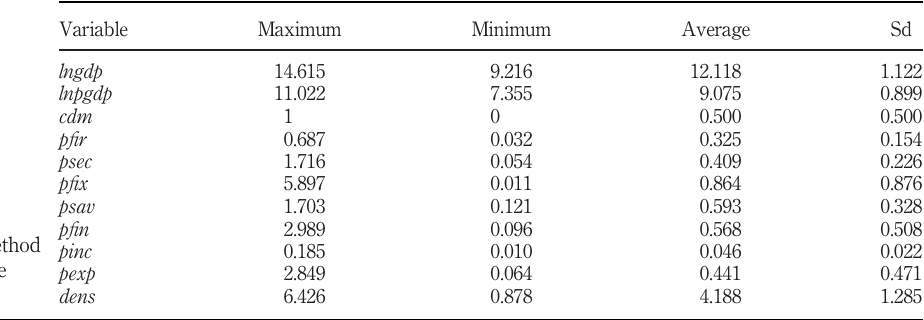
Table 3. Meaning and